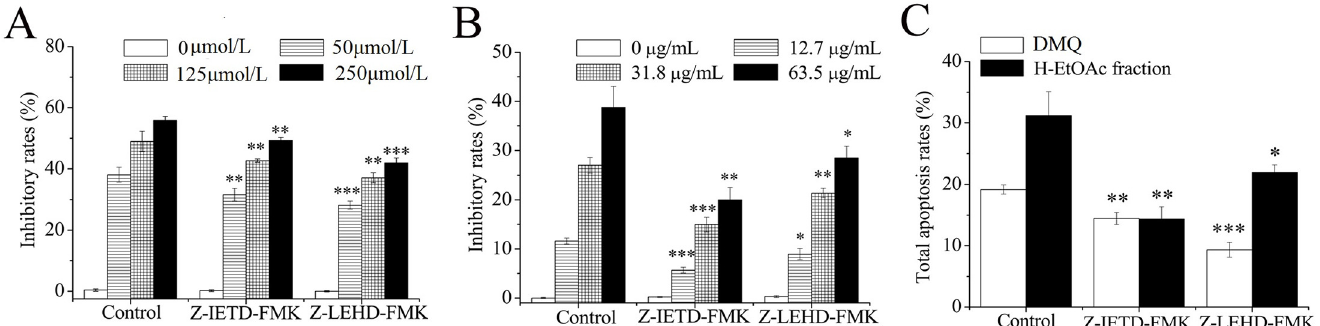
Fig 6. Caspase-8 and Caspase-9 Dependent Apoptosis of HepG2 Cells Induced by DMQ and H-EtOAc Fraction. A. HepG2 cells were incubated with caspase-8 inhibitor (Z-IETD-FMK: 20 μ mol/L) or caspase-9 inhibitor (Z-LEHD-FMK: 20 μ mol/L) for 30 min followed by DMQ at 0, 50, 125 and 250 μ mol/L for 24 h, the inhibitory rates were detected by SRB assays. B. HepG2 cells were incubated with Z-IETD-FMK or Z-LEHD-FMK for 30 min and subsequently treated with H-EtOAc fraction at 0, 12.7, 31.8 and 63.5 μ g/mL for 24 h, and the inhibitory rates were determined by SRB assays. C. HepG2 cells were pre- incubated with Z-IETD-FMK or Z-LEHD-FMK for 30 min before treated with DMQ (79 μ mol/L) or H-EtOAc fraction (100 μ g/mL) for 24 h, the cellular apoptotic rates were measured by flow cytometry. Values are means ± SD of three independent experiments. * ( p < 0.05), ** ( p < 0.01) and *** ( p < 0.001) represented significant differences compared to the